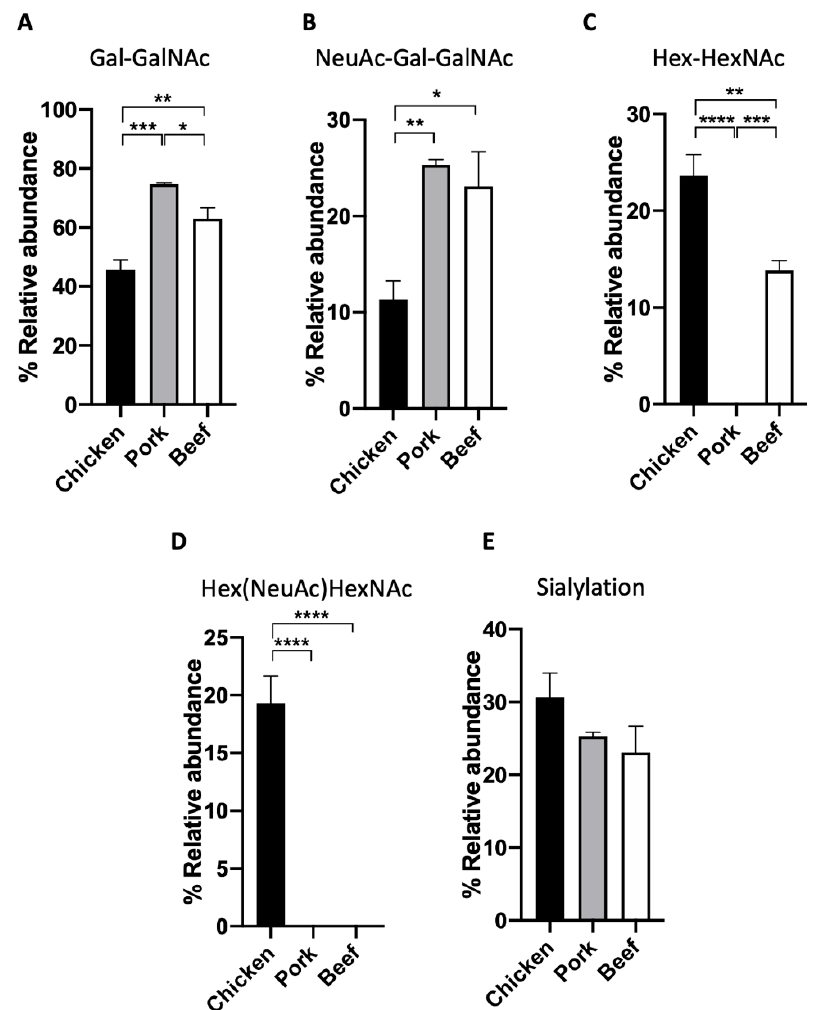
Figure 3. The relative abundance of permethylated O-glycans in meat samples. ( A ) Gal-GalNAc, ( B ) NeuAc-Gal-GalNAc, ( C ) Hex-HexNAc, ( D ) Hex(NeuAc)HexNAc, and ( E ) sialylation of chicken, pork and beef. (One-way ANOVA followed by Tukey’s post hoc test, multiple comparisons were performed between chicken, pork, and beef, n = 4; * p < 0.05; ** p < 0.01; *** p < 0.001; **** p < 0.0001.) Table 1. Summary of relative abundances of O-glycans in percentage detected in chicken, pork, and beef. (±, standard error of mean; ND, not detected).